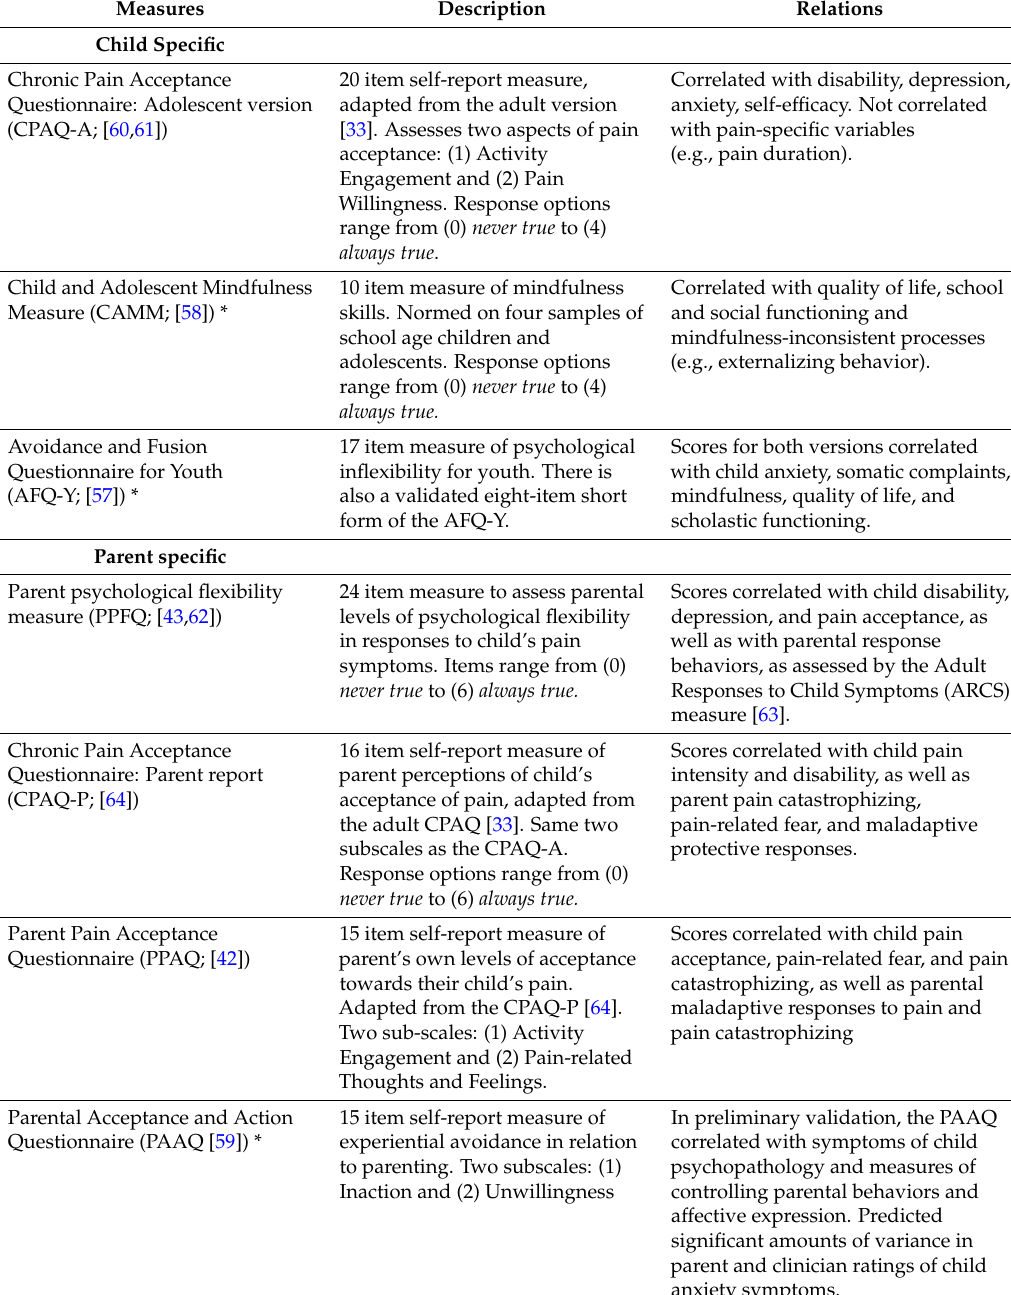
Table 1. Measures of Acceptance and Commitment Therapy (ACT) processes in pediatric chronic